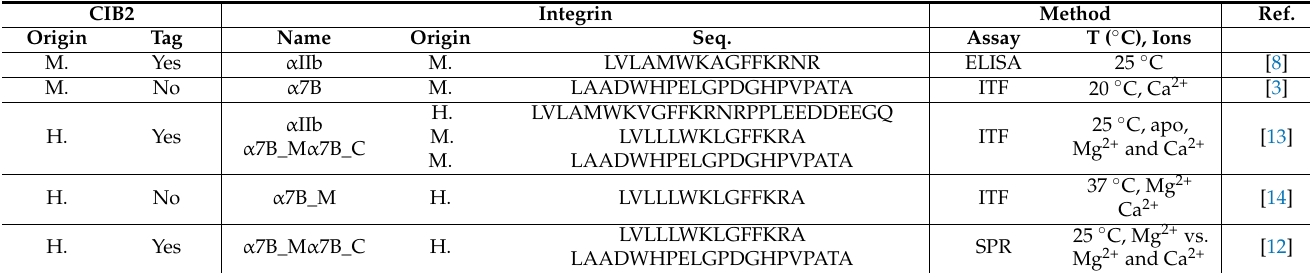
Table 1. Summary of CIB2–integrin interaction